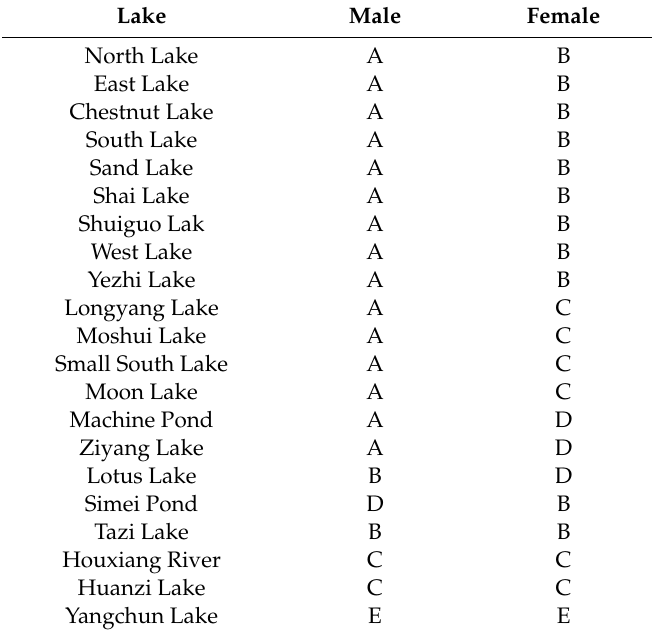
Table 5. Attributes of each lake among users of di ff erent